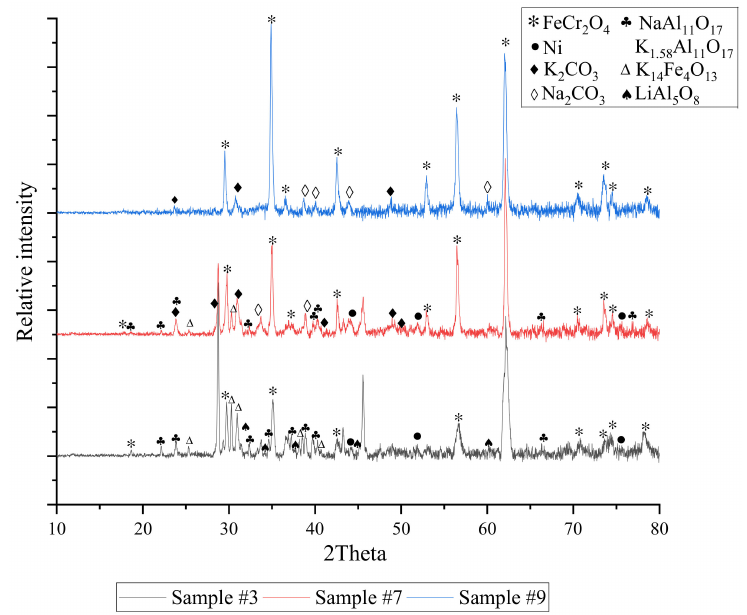
Figure 3. Selected XRD patterns of vessel samples #3, #7, and #9 after 4000 h exposure to evaporated alkali carbonates at different temperatures depending on the sample position, see Figure 1c.